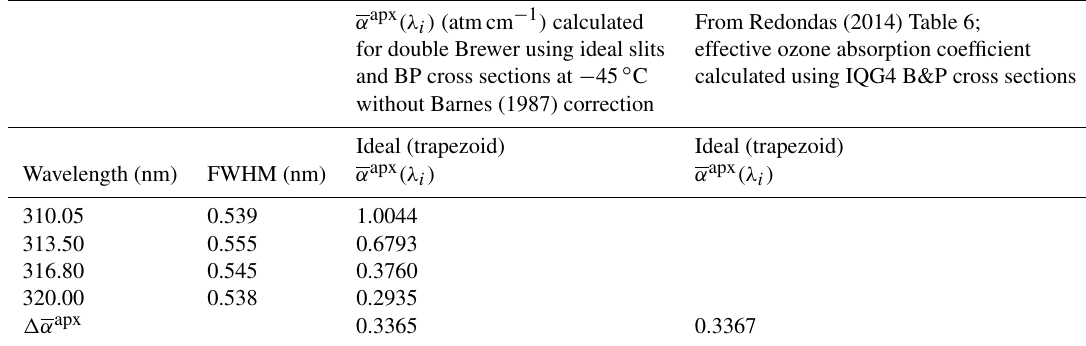
Table 3. Ozone absorption coefficients calculated here and the value calculated by Redondas et al.